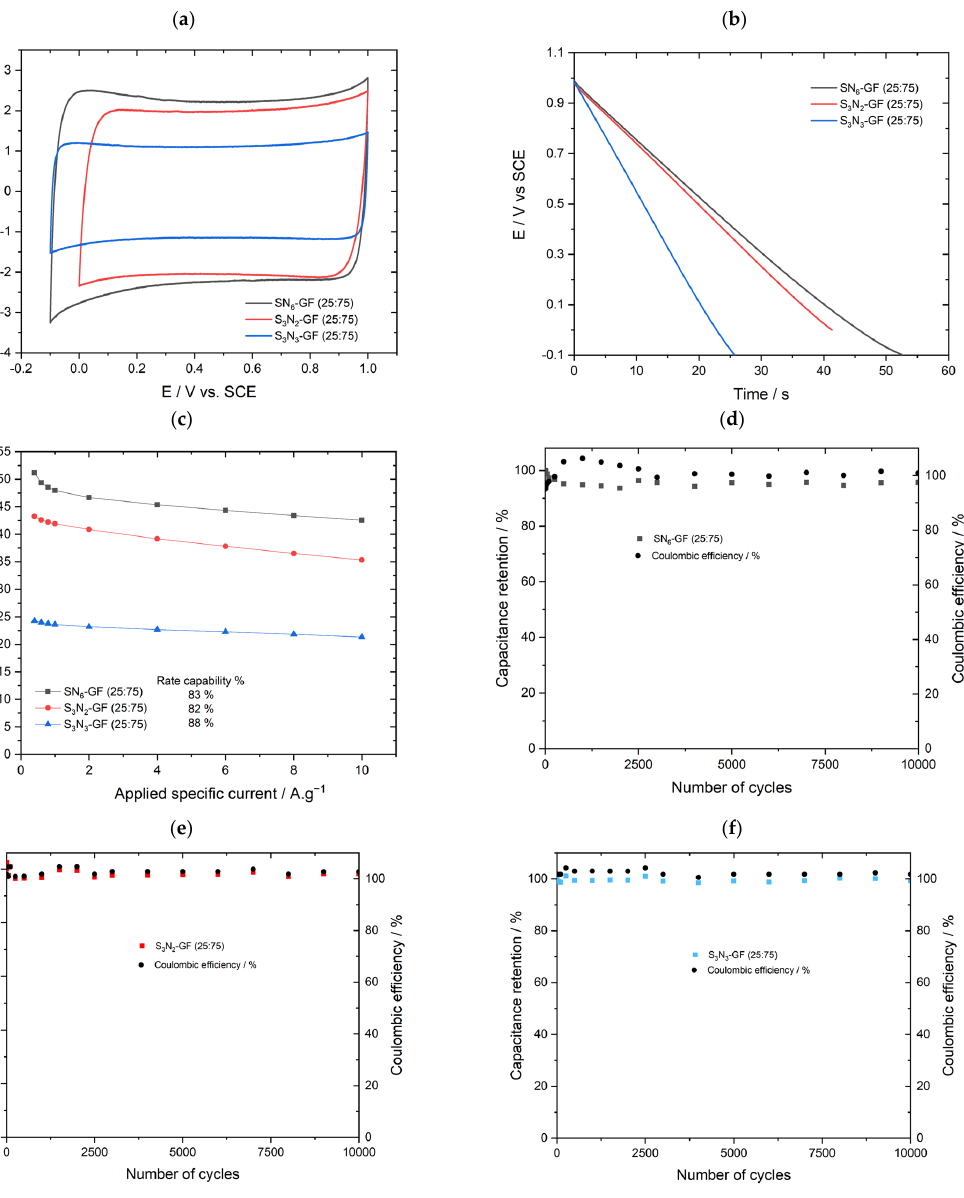
Figure 4. Electrochemical results for different dopants and different dopant ratios in 1 M Na 2 SO 4 electrolyte, for SN 6 − GF (25:75), S 3 N 2 − GF (25:75), and S 3 N 3 − GF (25:75): ( a ) cyclic voltammetry at 50 mV ∙ s − 1 ; ( b ) discharge curves at 1.0 A ∙ g − 1 ; ( c ) specific capacitance at specific current from 0.4 A ∙ g − 1 to 10.0 A ∙ g − 1 ; and capacitance retention after 10,000 cycles of continuous charge–discharge at 10.0 A ∙ g − 1 for ( d ) SN 6 − GF (25:75), ( e ) S 3 N 2 − GF (25:75) and ( f ) S 3 N 3 − GF (25:75).